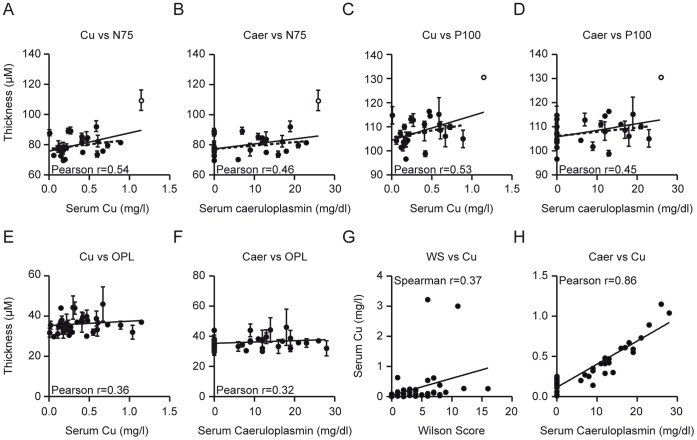
Correlations between layers, VEP parameters and laboratory. A–HThe significant correlations between the laboratory parameters and the mean thickness of the retinal layers and VEP parameters of both eyes are shown and the Pearson or Spearman r is indicated (p<0.05 including the outlier, all comparisons were made using a Pearson analysis except for the Wilson Score, which was analyzed using a Spearman analysis). A–D The continuous lines resemble linear regressions including, and the dotted lines excluding, an outlier with beginning hepatic failure (the outlier is marked as unfilled dot, Pearson r is indicated considering the outlier).